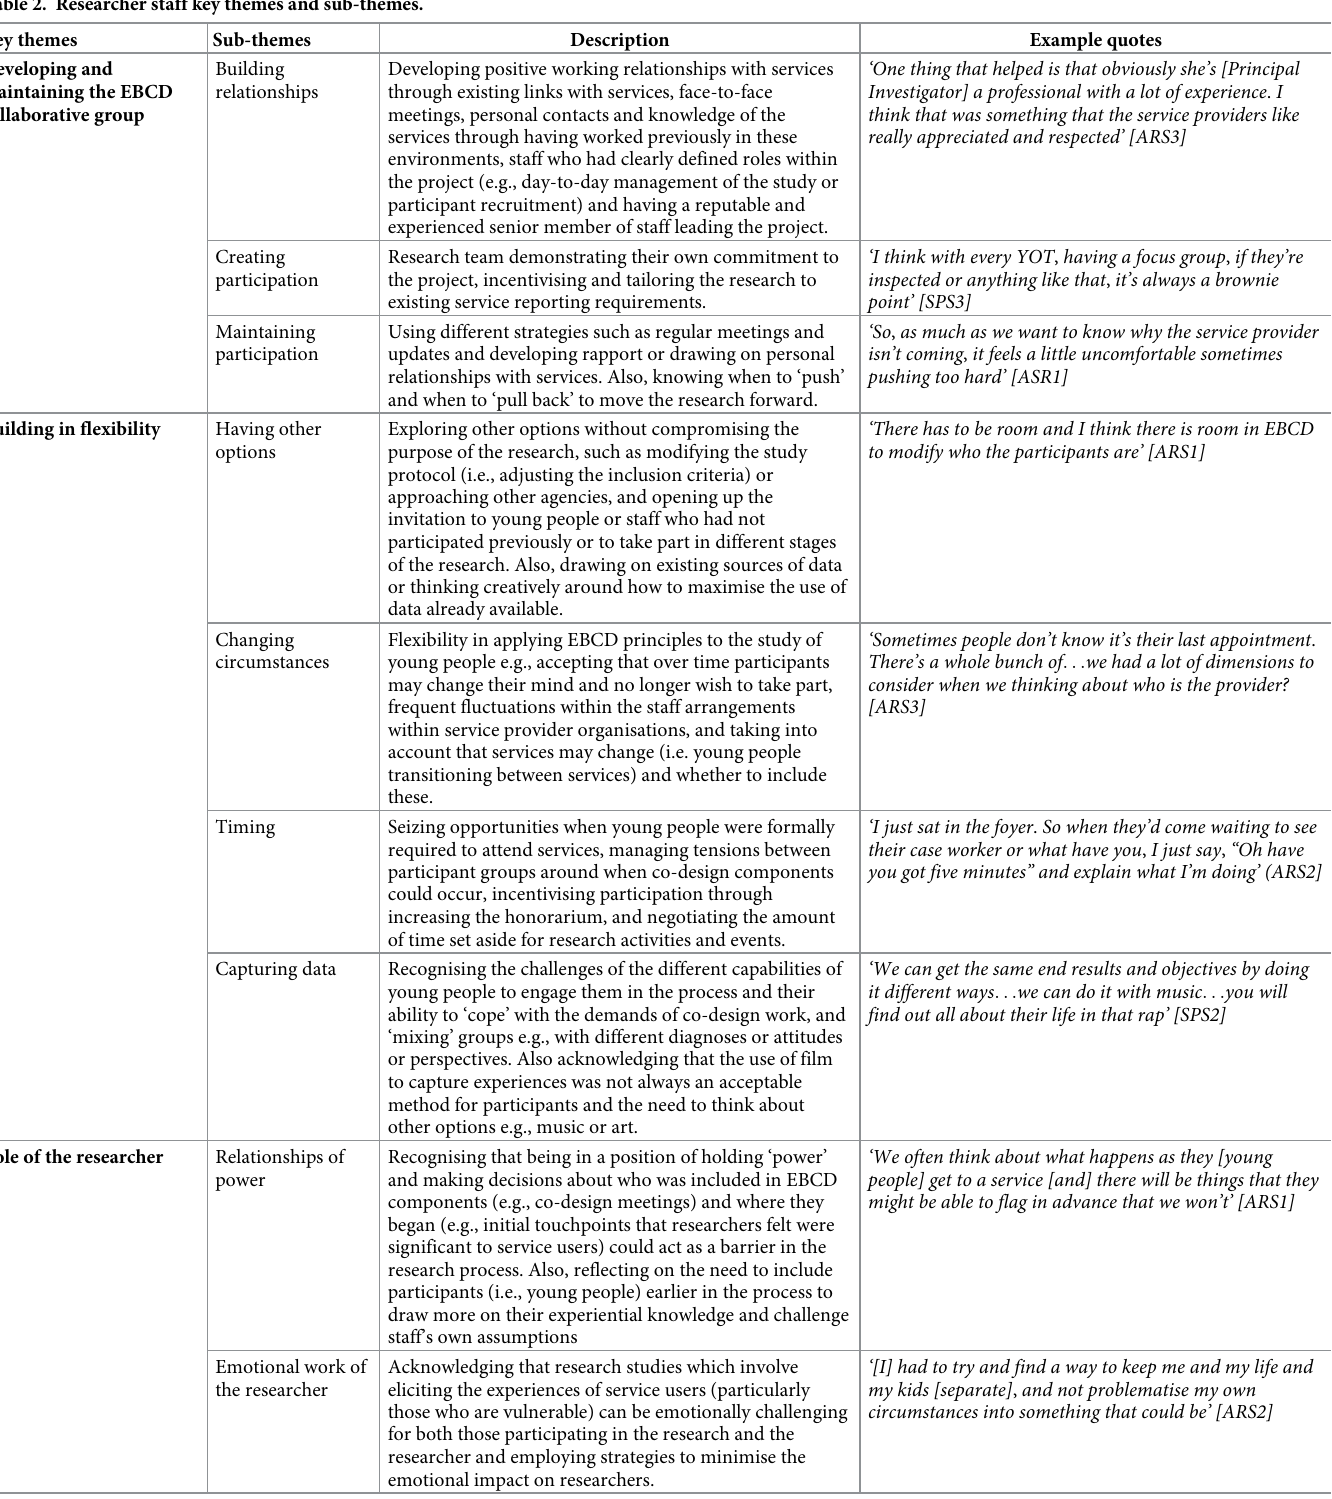
Table 2. Researcher staff key themes and